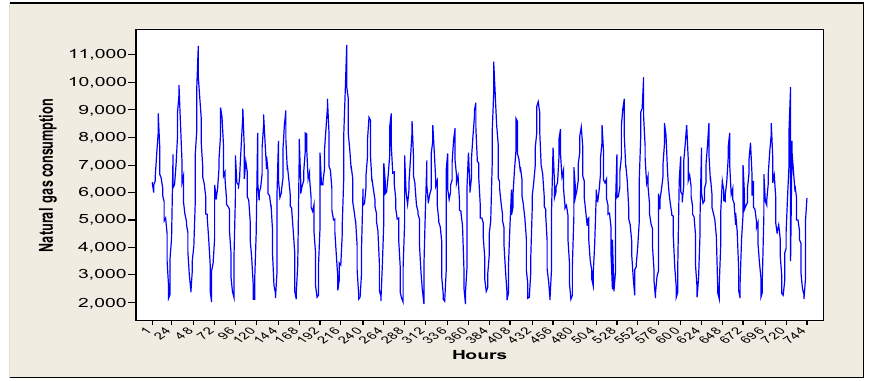
Figure 1. Time plot of the Egyptian hourly